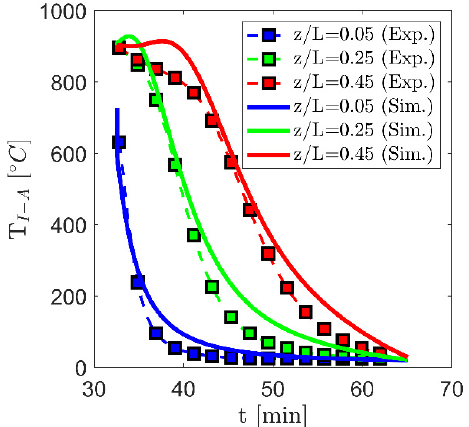
Figure 10. Transient temperature profiles in the honeycombs at z/L = 0.05 (T I-A-1 ), 0.25 (T I-A-2 ), 0.45 (T I- A-3